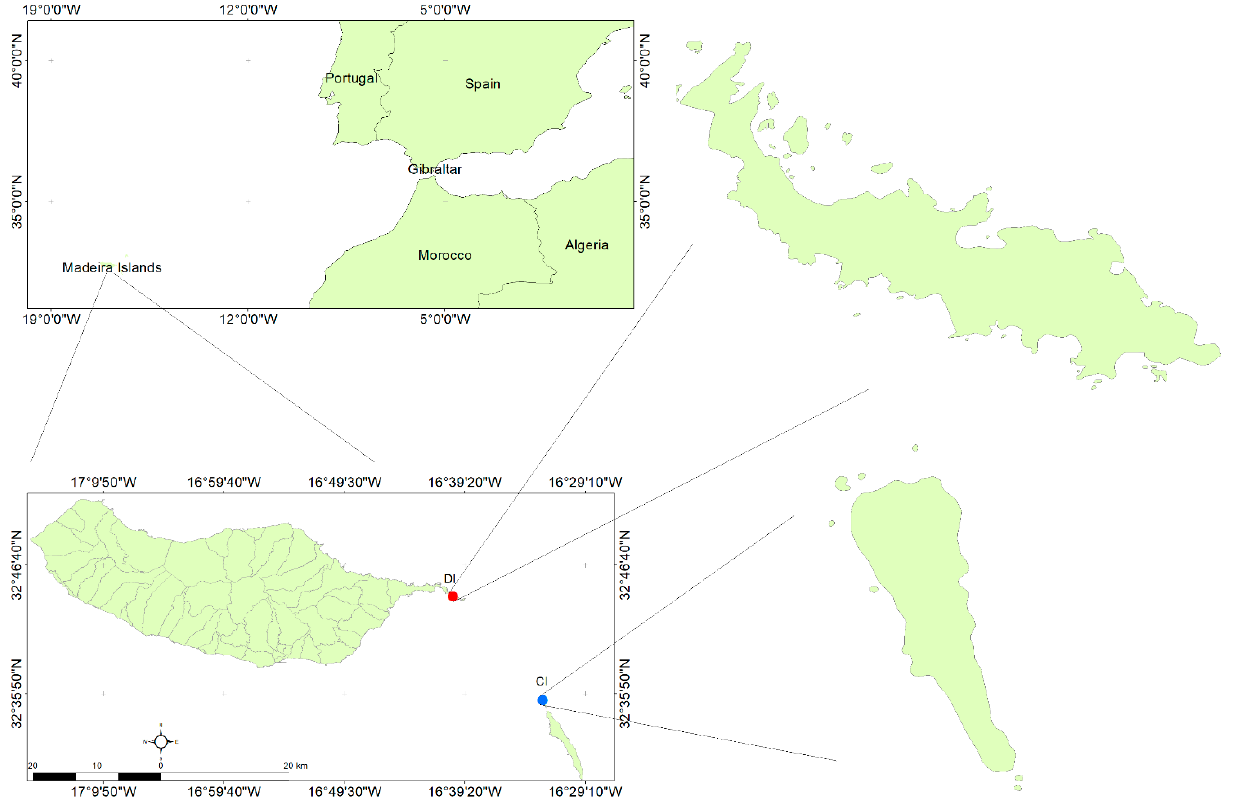
Figure 1. Map showing sites from Madeira where individuals of Beta patula were sampled, Desembarcadouro islet (DI, red dot) and Chão islet (CI, blue dot).